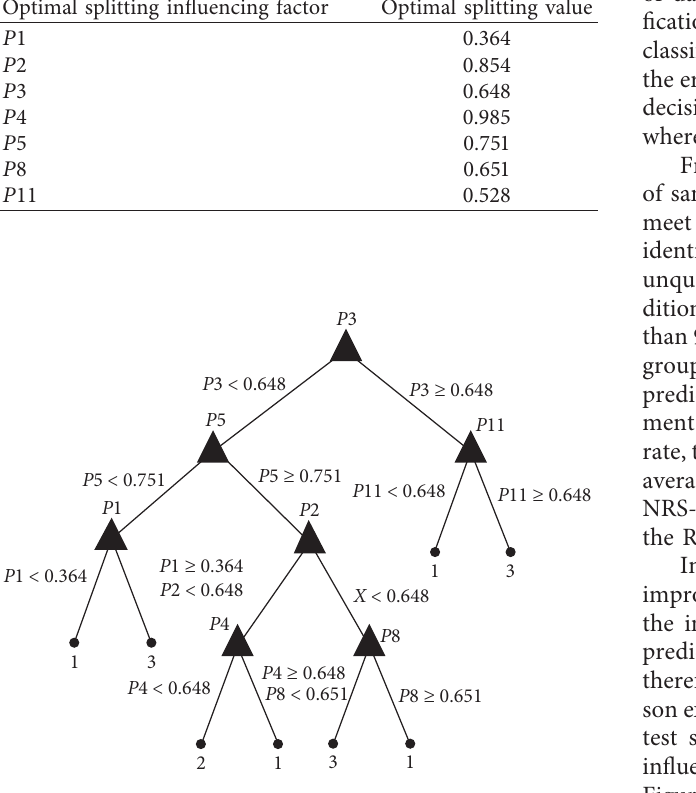
Figure 7: Decision tree structure.